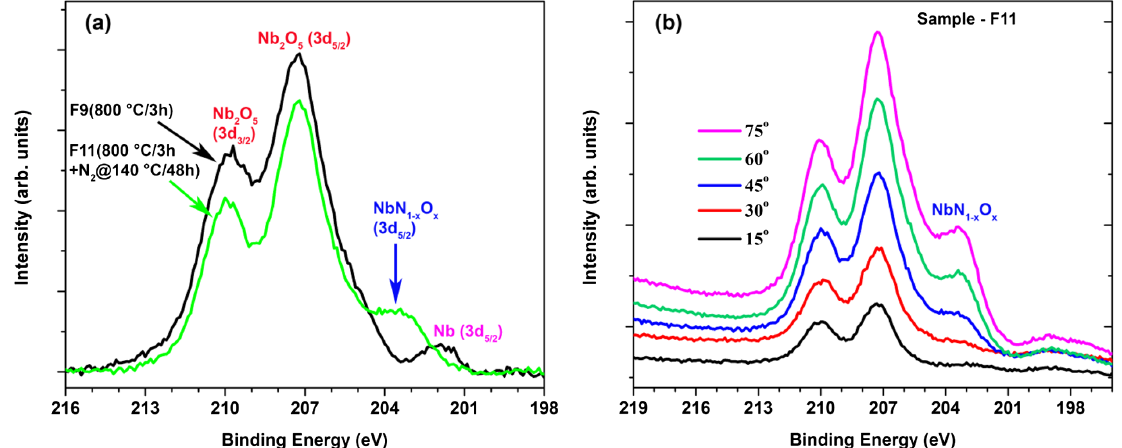
FIG. 6. (a) Background subtracted XPS spectra on sample F9 ( 800 °C = 3 hrs) and F11 ( 800 °C = 3 hrs þ 140 °C = 48 hrs @ 25 mTorr N 2 ) at 45° takeoff angle. (b) Angle resolved XPS on sample F11.